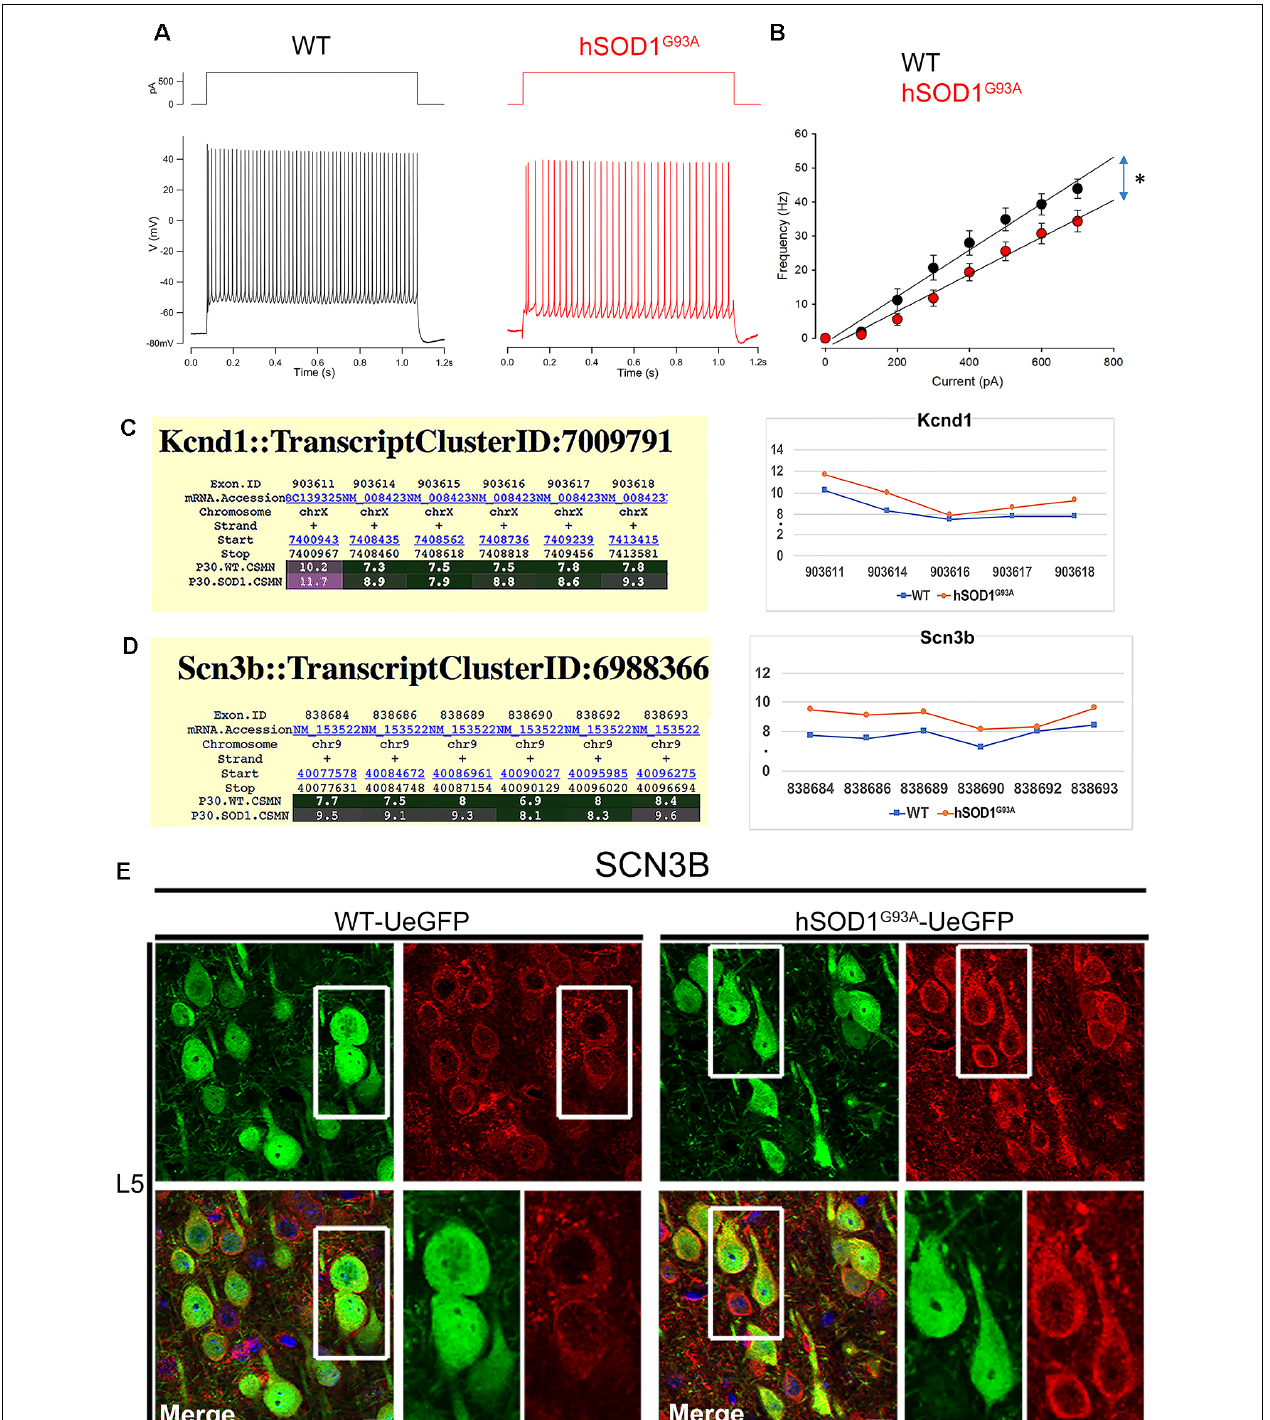
FIGURE 5 | The excitability of CSMN in hSOD1 G93A mice. The excitability was measured as the number of action potential fired in response to 1 s depolarizing current steps of increasing amplitudes ( ∆ 0.05 nA). (A) Representative responses of WT and hSOD1 G93A CSMN to a 0.4 nA current step. (B) Average f-I curve of CSMN in WT and hSOD1 G93A mice. WT (black; n = 9) and hSOD1 G93A (red; n = 13). (C) Gene expression analysis of Kcnd1. Expression values for each exon are plotted to the right. (D) Gene expression analysis of Scn3b. Expression values for each exon are plotted to the right. (E) Representative images of Scn3b expression in L5 motor cortex of WT-UeGFP (left) and hSOD1 G93A -UeGFP (right). CSMN (green) and Scn3b (red); insets are enlarged in the bottom right panels. Scale bar: 20 µ m; ∗ p ≤ 0.05.